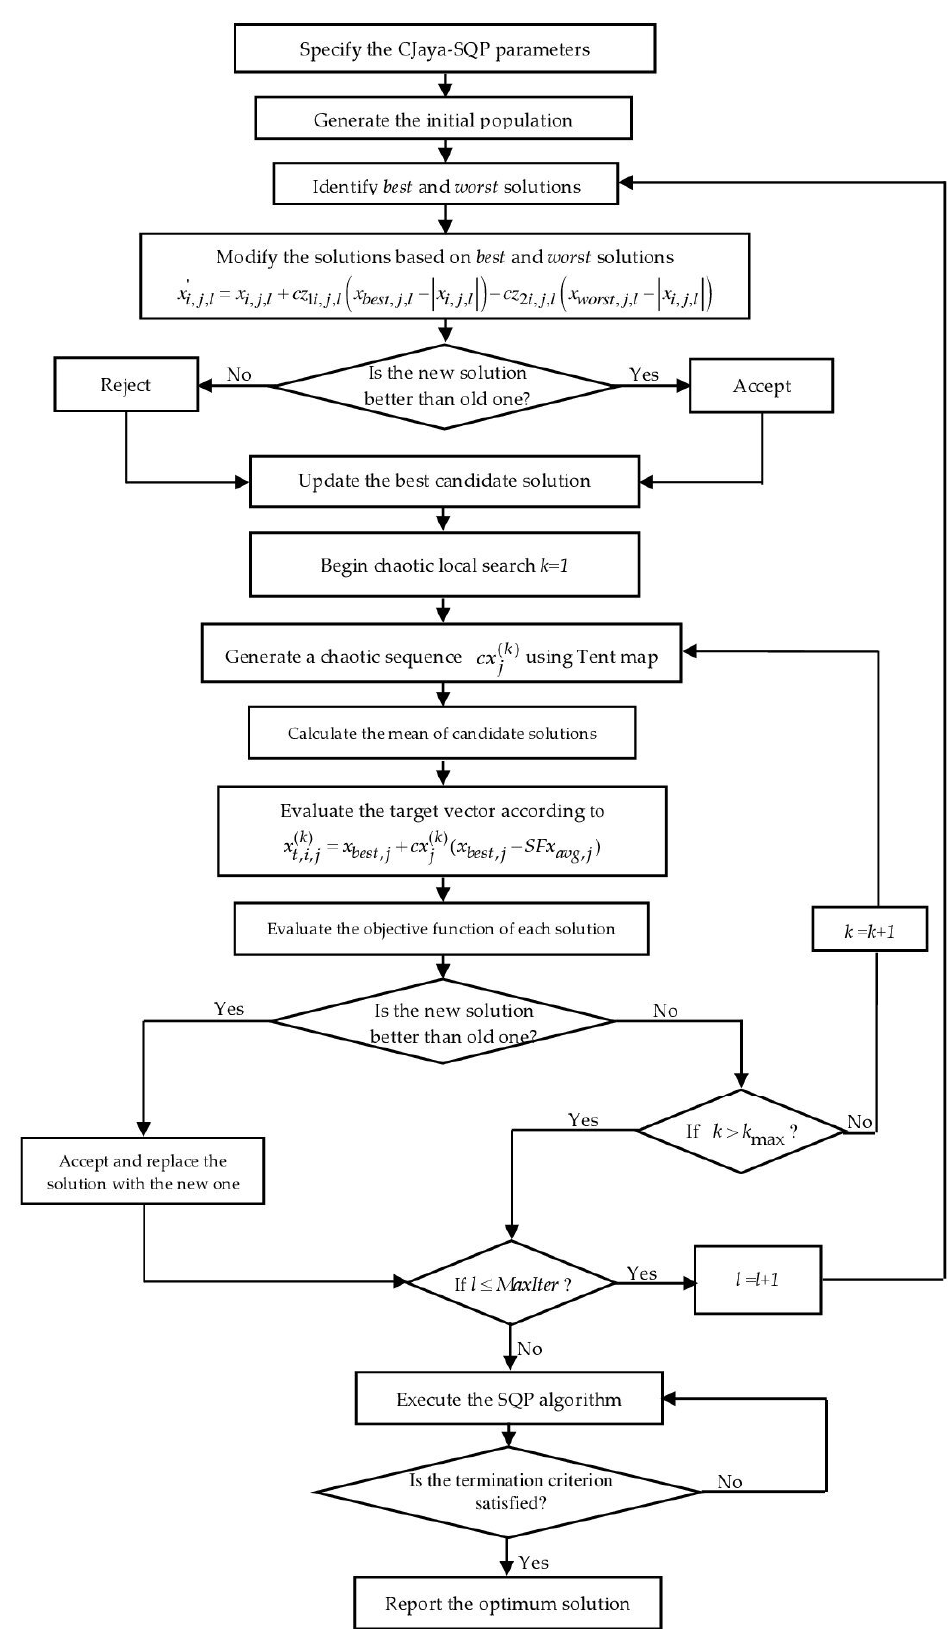
Figure 4. Flowchart of the proposed CJaya-SQP algorithm.